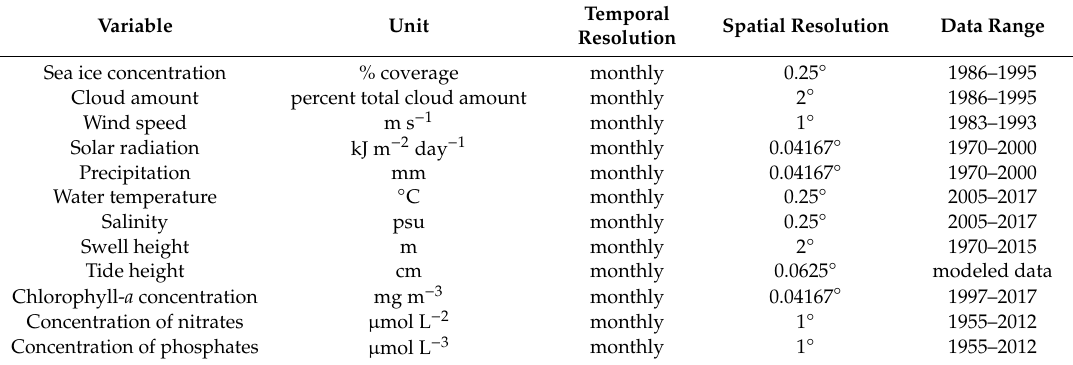
Table 2. The spatial and temporal resolution, data range and units of environmental variables used in the